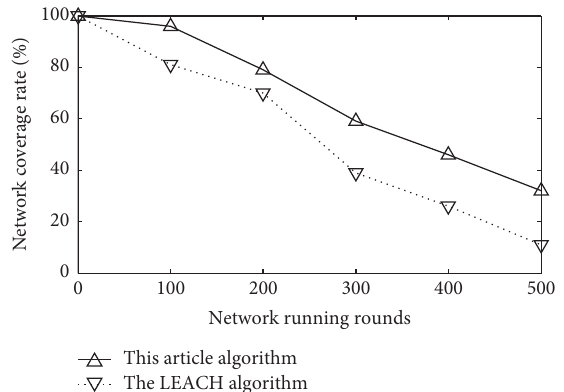
Figure 11: Network coverage rate comparison in this article’s algorithm and the LEACH algorithm under different network running rounds.